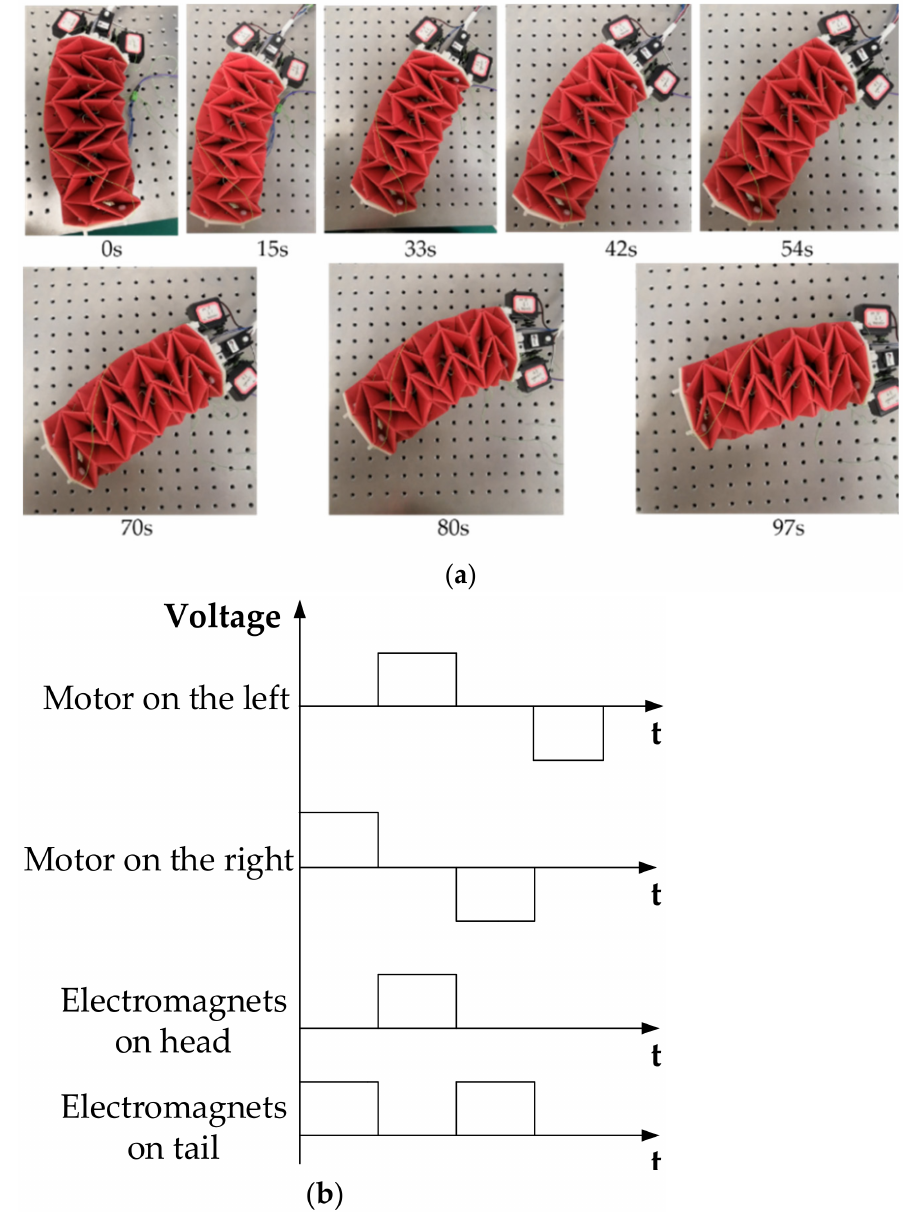
Figure 26. Origami crawling robot with electromagnetic sliding feet on an iron plane: ( a ) top view of right-turning motion; ( b ) control signals of motors and electromagnets of right-turning